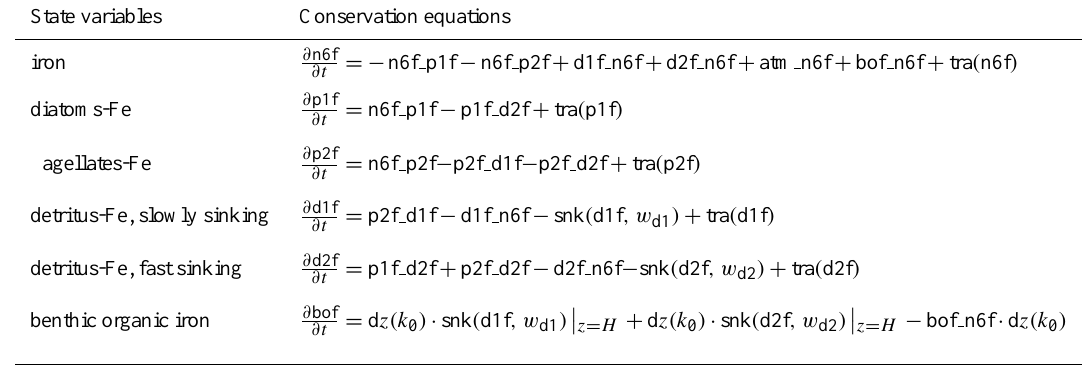
Table A2. The biogeochemical conservation equations of ECOHAM4 concerning iron. The equations for the state variables make use of fluxes between state variables; a flux from variable var1 to variable var2 is denoted by the acronym var1 var2. Transport tra(var1) includes vertical mixing mix(var1); snk (dxf, w d x ) indicates the change of d x f ( x = 1 , 2) concentration due to sinking; water depth is H and k 0 denotes the index of the deepest pelagic layer.